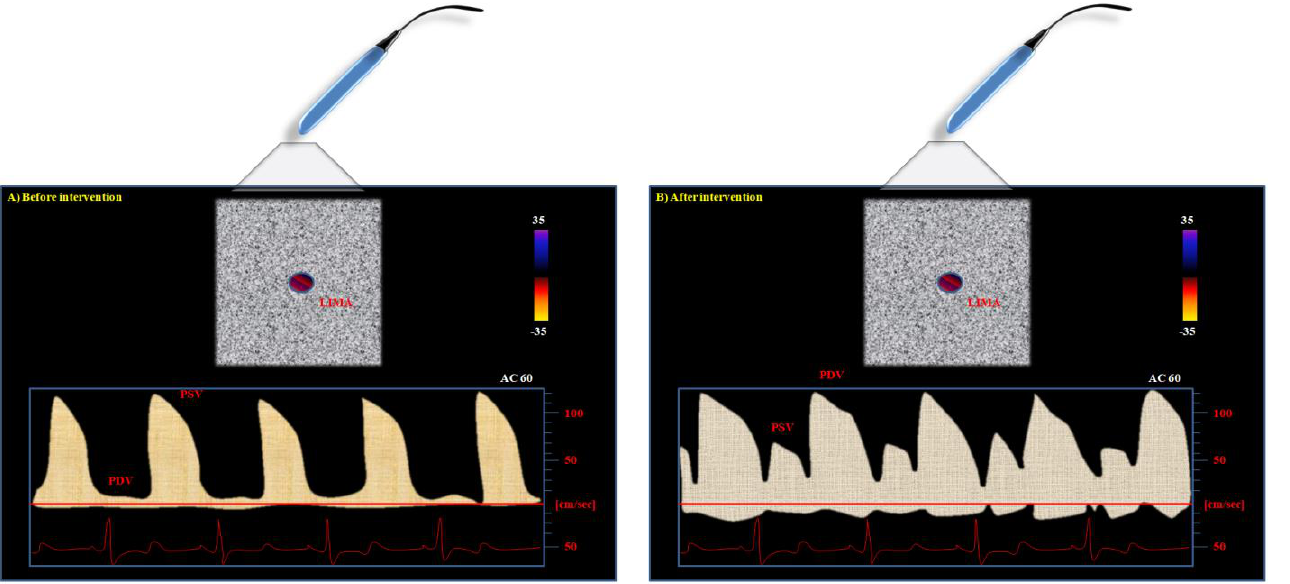
Figure 2. Left internal mammary artery (LIMA) continuous-wave color Doppler flow aspect from the supraclavicular window: ( A ) before aorto-coronary bypass graft (CABG) intervention, and ( B ) after CABG intervention. The differences in Doppler profile (i.e., peak systolic (PSV) and diastolic (PDV) velocities) can be observed.